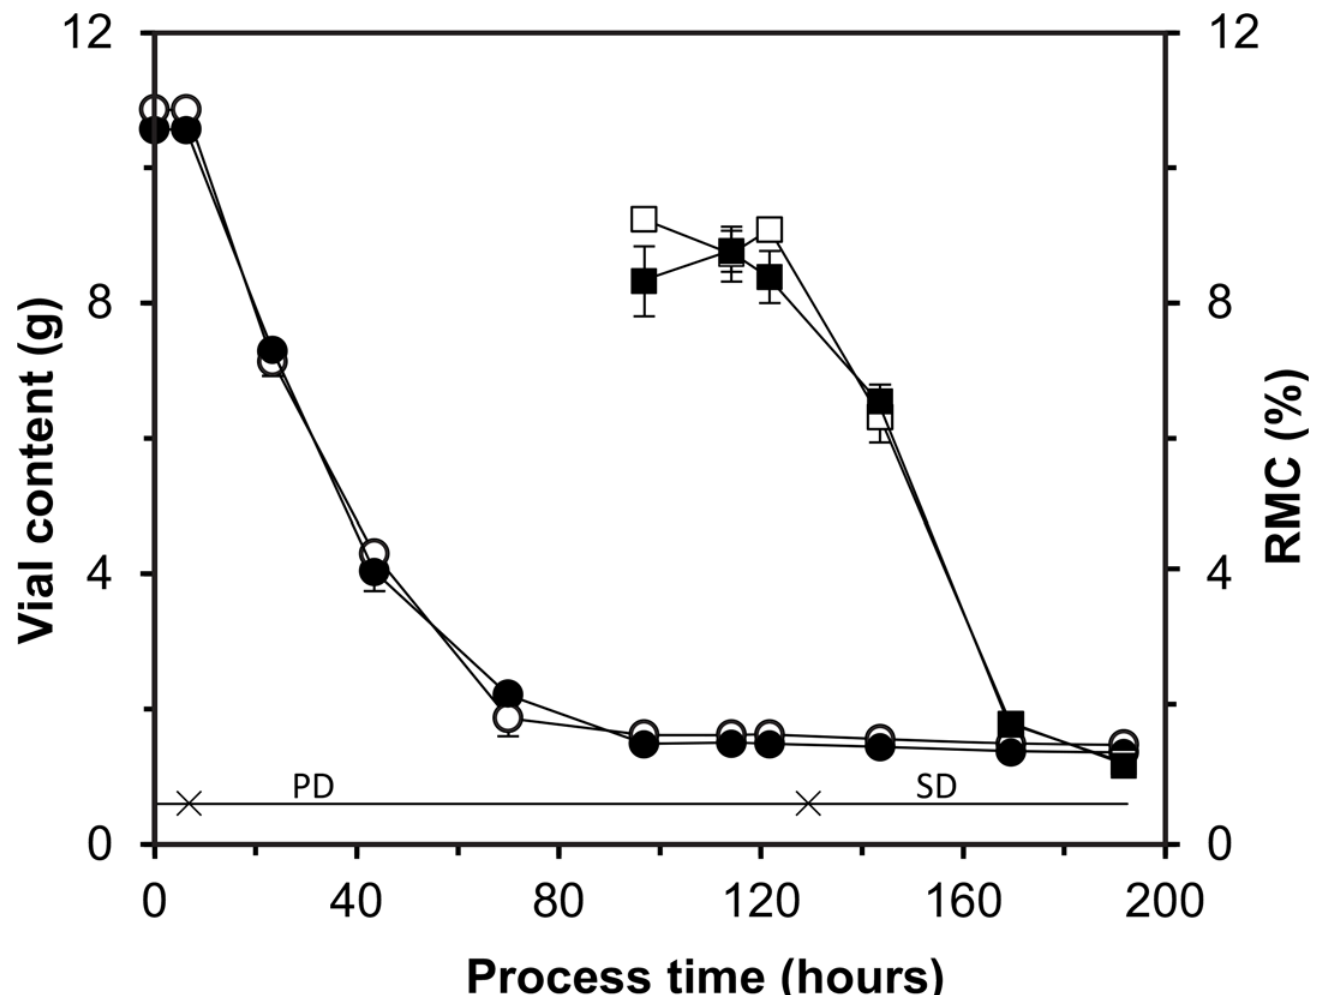
Fig 4. Freeze-drying of 10 mL HGT-medium and BCG in HGT-medium in the pilot freeze-dryer. Depicted are: the vial content (g) of BCG in HGT- medium (black circle) and HGT-medium (clear circle) and the RMC (%) of BCG in HGT-medium (black square) and HGT-medium (clear square). Each dot represents an average value ± standard deviation (n = 3). The solid horizontal line shows represent the total process time. The stars mark the beginning of primary, and secondary